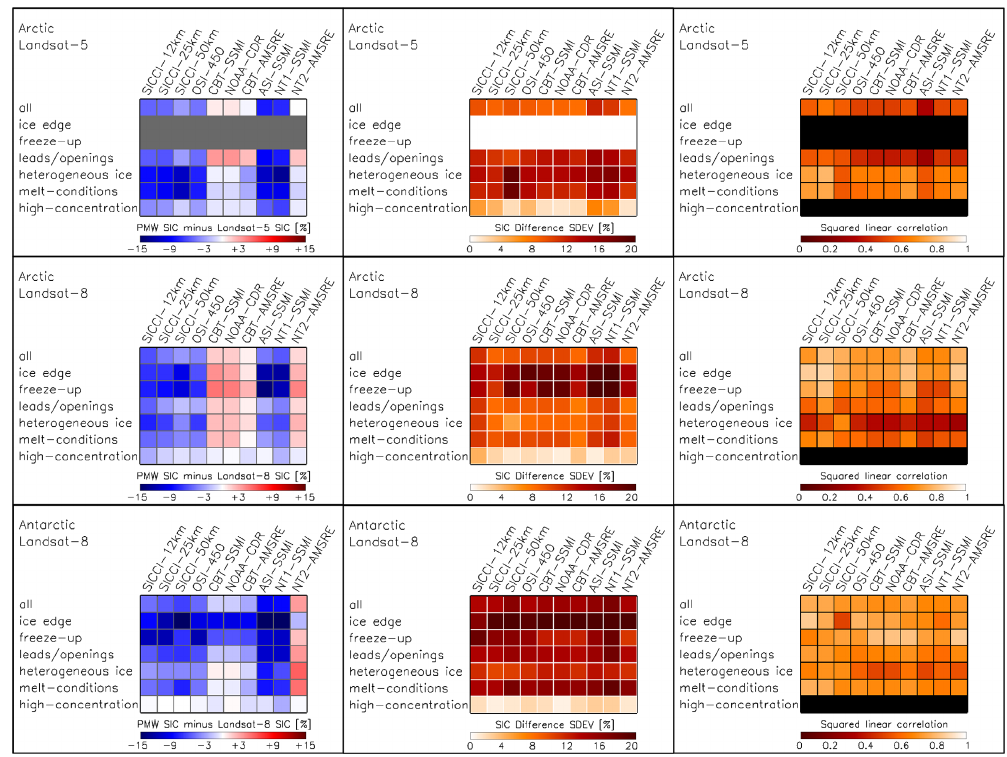
Figure 12. Illustration of the statistical parameters of the comparison between Landsat SIC and PMW SIC for all ice regimes. Rows denote, from top to bottom, first-year ice Arctic (Landsat-5), mixed first-year–multiyear ice and multiyear ice Arctic (Landsat-8), and all ice Antarctic (Landsat-8). Columns denote, from left to right, accuracy (difference PMW SIC minus Landsat SIC), precision (standard deviation of the SIC difference), and squared linear correlation coefficient. The uni-colored rows denote cases left out either because these ice regimes are not populated (topmost row of panels) or because the retrieval of parameters did not make sense (squared linear correlation for ice regime “high concentration”). Note “AMSRE” refers to both AMSRE (Landsat-5) and AMSR2